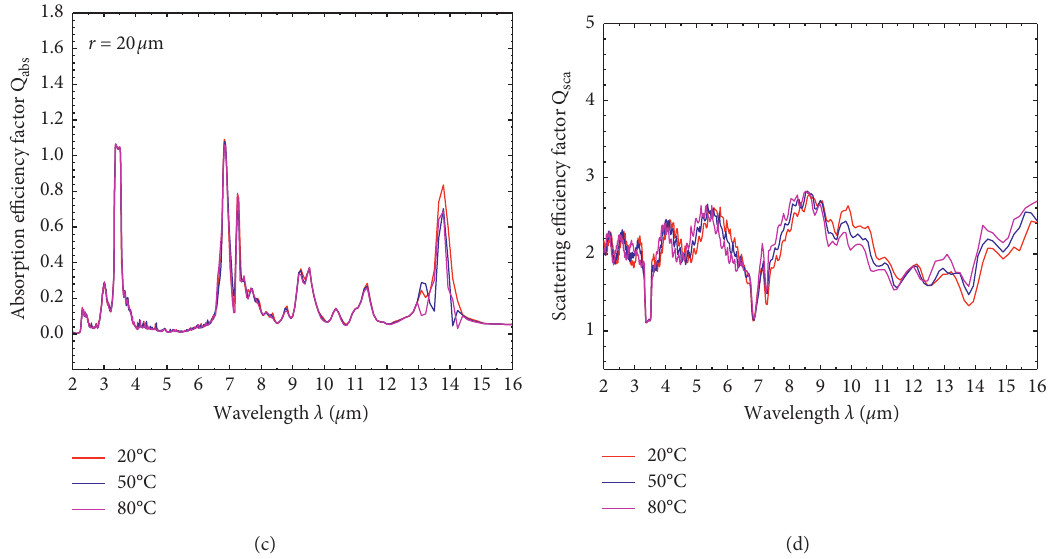
Figure 3: Absorption and scattering efficiency factors of a single spherical n-octane droplet with r � 10, 20 μ m.